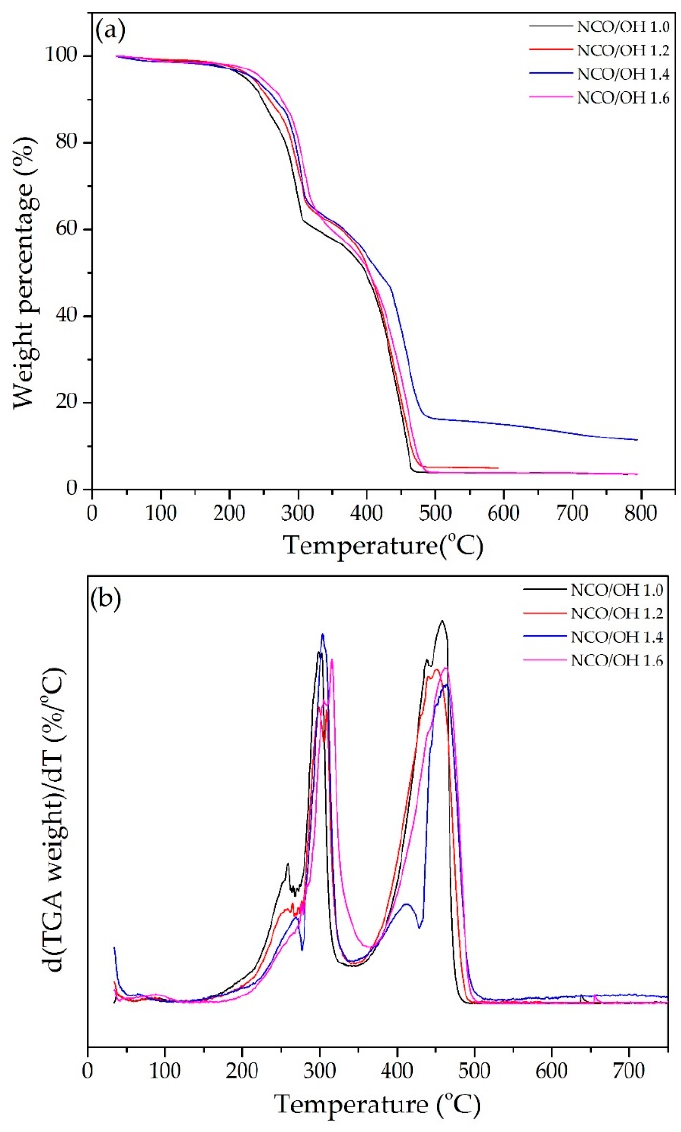
Figure 5. ( a ) Thermogravimetric analysis (TGA) curves and ( b ) their derivative curves of PU-DOD with different NCO/OH